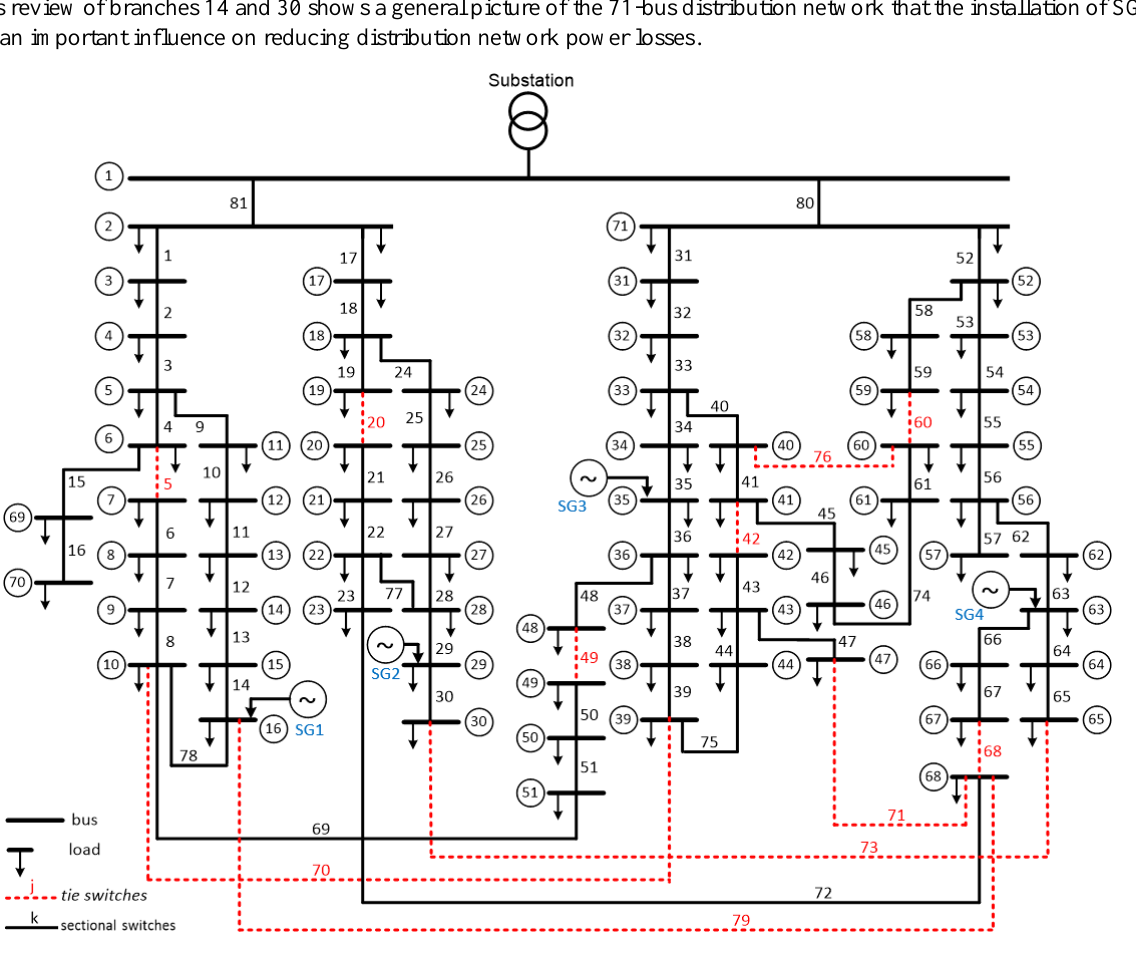
Figure 14. Final configuration of IEEE model distribution network 71-bus with integration of four